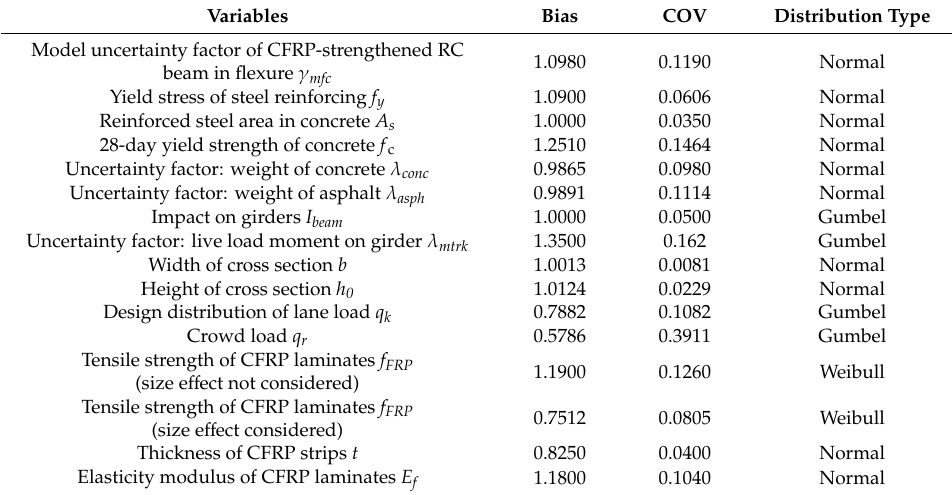
Table 3. Statistical properties of variables